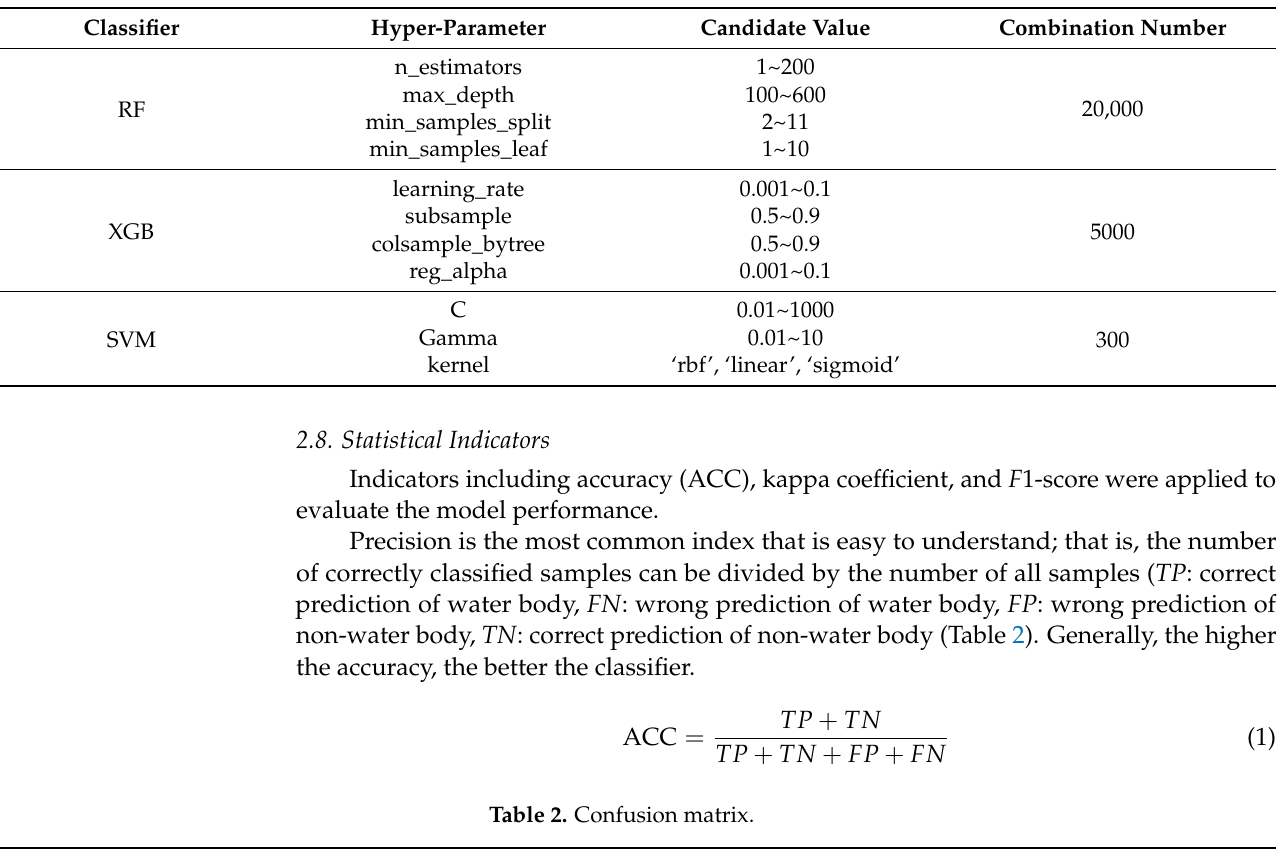
Table 1. Hyper-parameters of the machine learning algorithm.